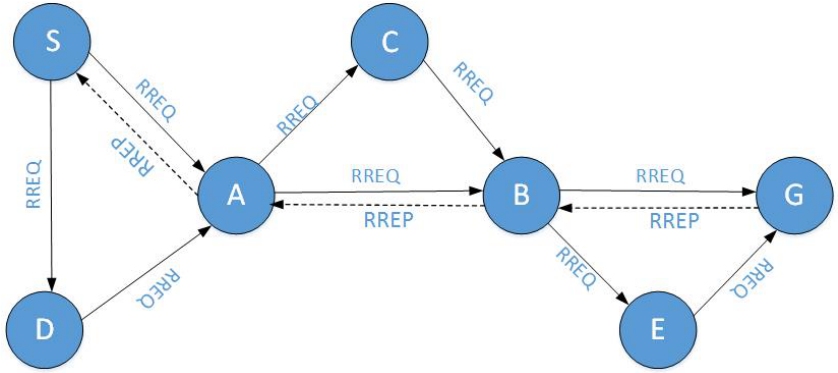
Figure 1. Architecture of On-demand Anonymous Routing